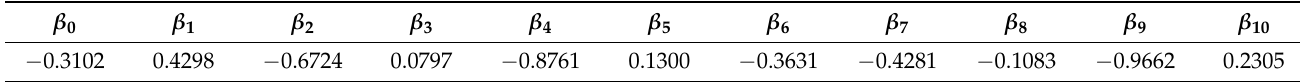
Table 19. Coefficients of AR(10) process for M4 x –the first difference.